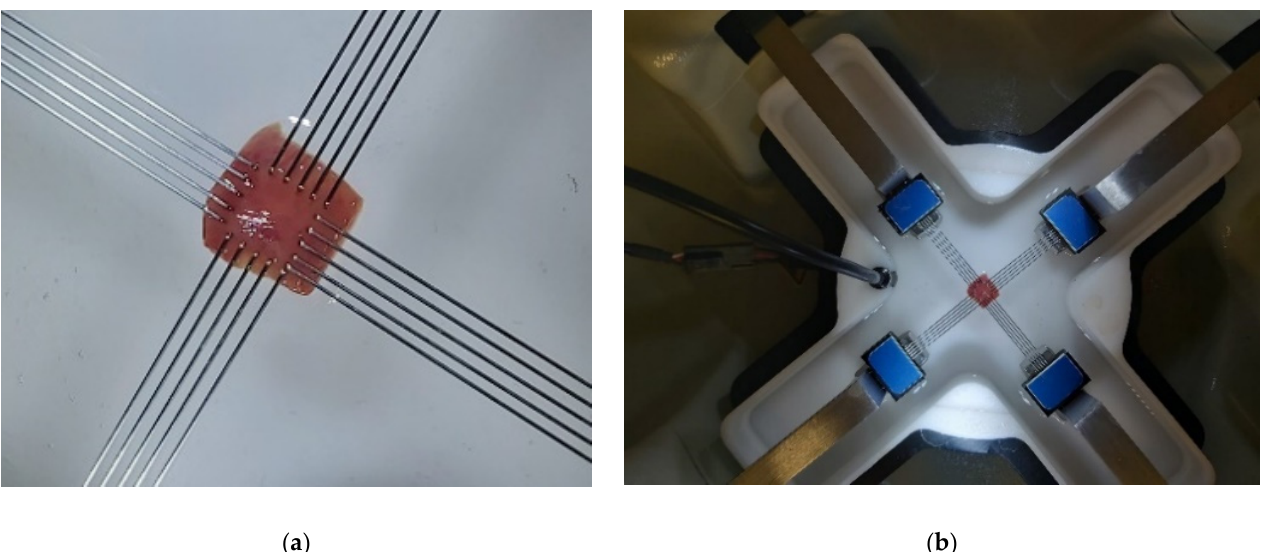
Figure 1. Experimental set-up of biaxial testing of rat heart passive myocardium: ( a ) shows the 5 × 5 mm LV myocardium sample and rake assembly for clamping, and ( b ) shows the BioTester system used for biaxial testing of rat LV myocardium including the water bath for mimicking the body temperature of 37 °C.